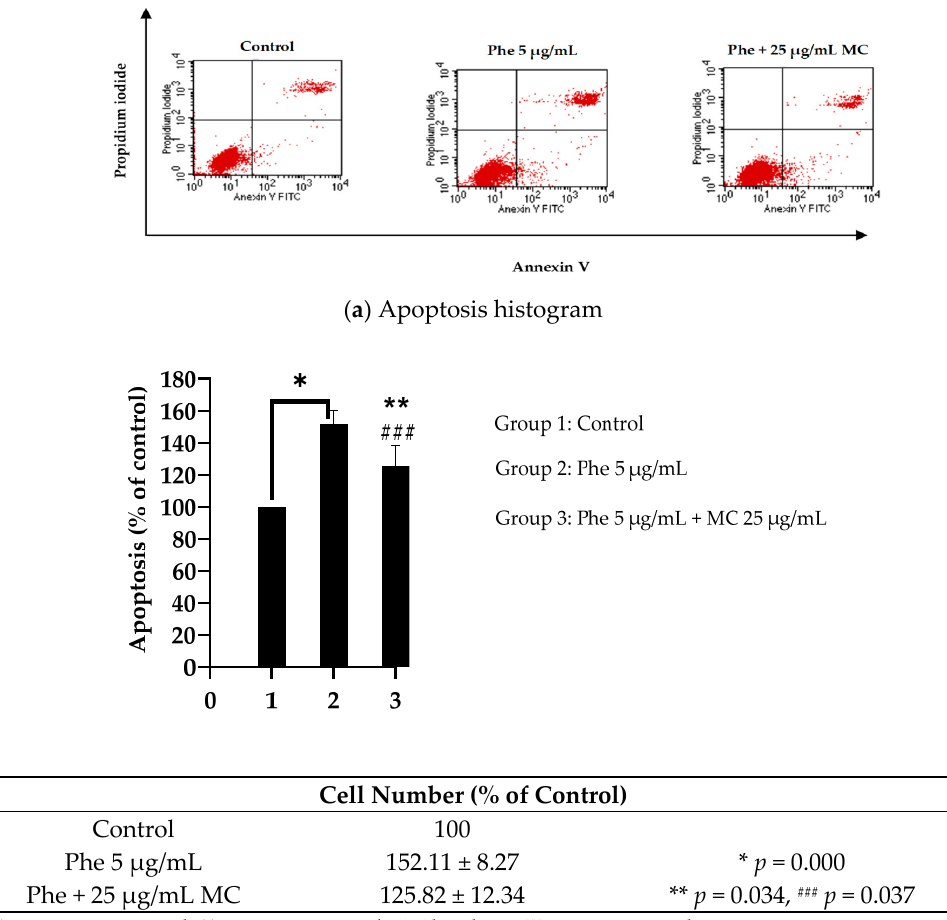
Figure 4. The anti-apoptotic effect of MC against PAHs in HT-22 cells. Apoptotic histograms from each experimental group showed ( a ). Population of apoptotic cells in each group is shown as bar graphs ( b ). * p < 0.05 vs. control (0 μ g/mL Phe); ** p < 0.05 vs. Phe alone. * p value was 0.000 in 5 μ g/mL Phe alone, ** p value was 0.034 in Phe group combined with 25 μ g/mL MC, and ### p value was 0.037 in Phe group combined with 25 μ g/mL MC compared with control group; n = 3.